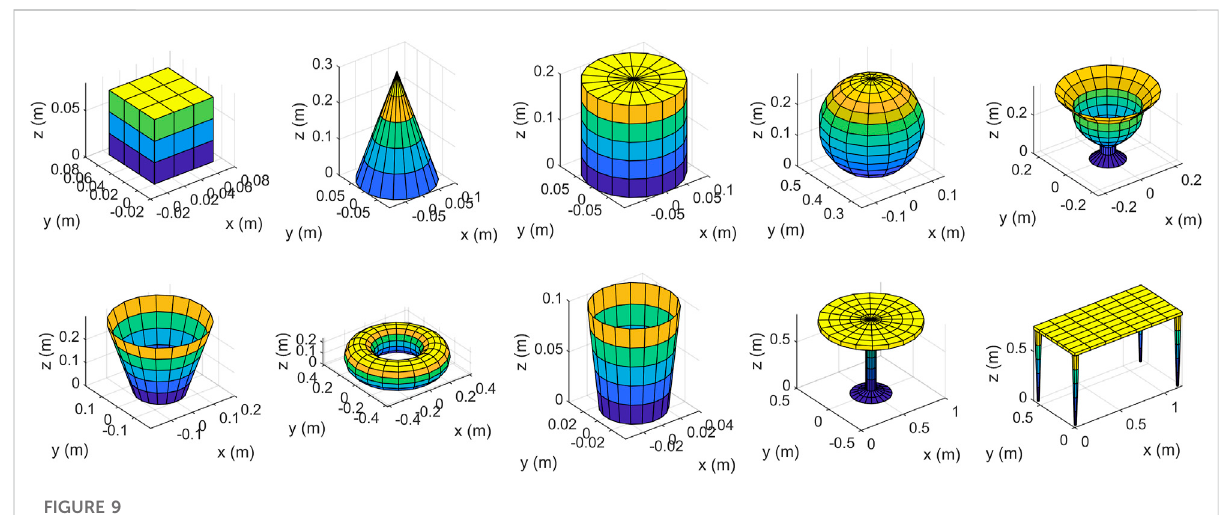
FIGURE 9 Some simple objects that we designed to test the proposed